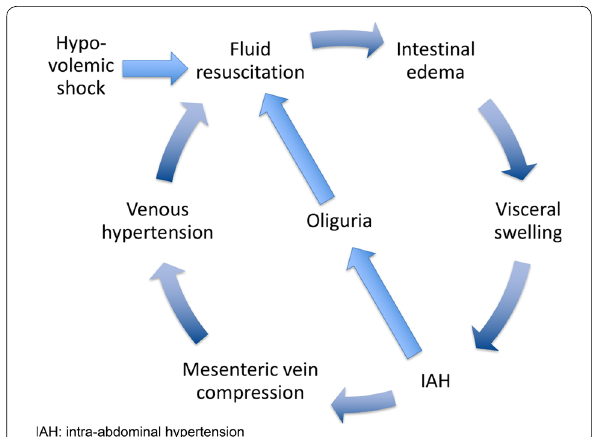
Fig. 1 The vicious cycle of septic shock resuscitation. Adapted from Peeters et al. with permission [96]. IAH: intra‑abdominal hypertension